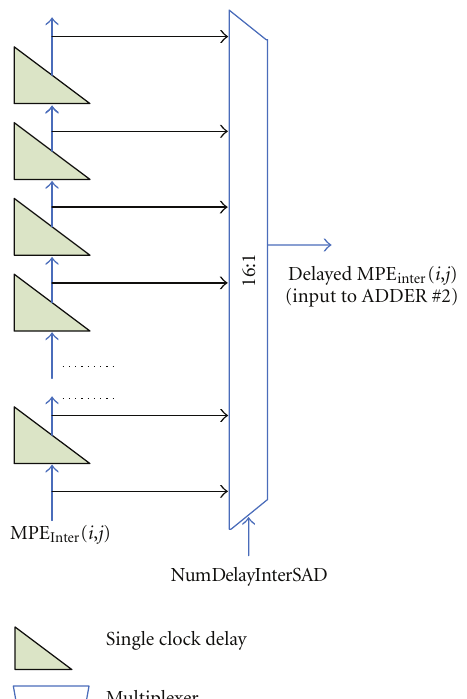
Figure 13: Resource overhead required to route output of ADDER number 1 into ADDER number 2 (refer Figure 12) after appropriate